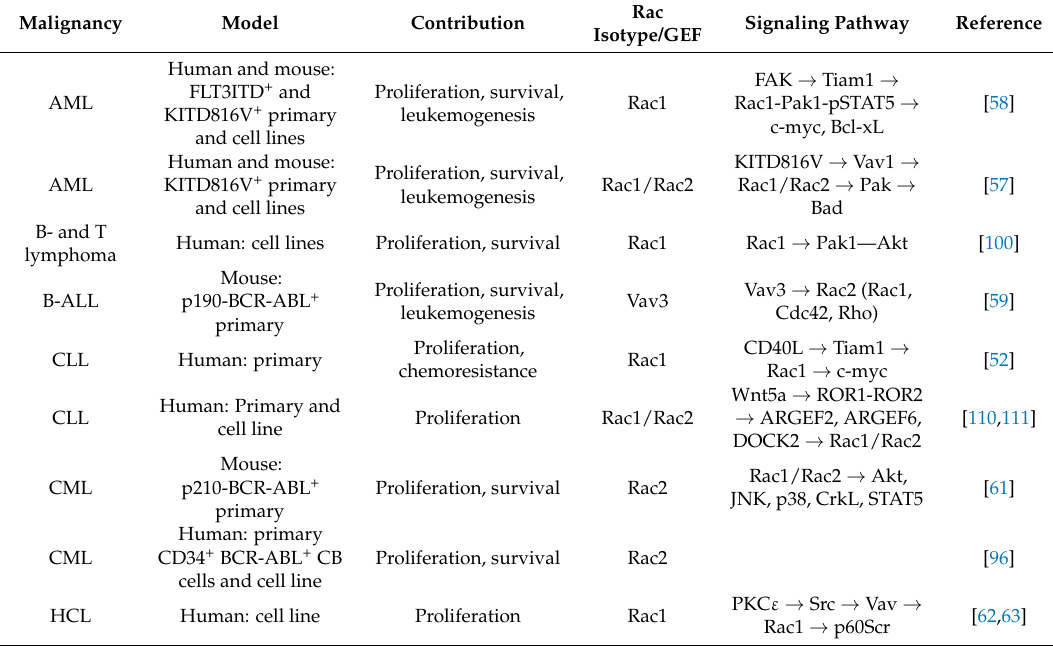
Table 4. Contribution of Rac to leukemic/lymphoma cell